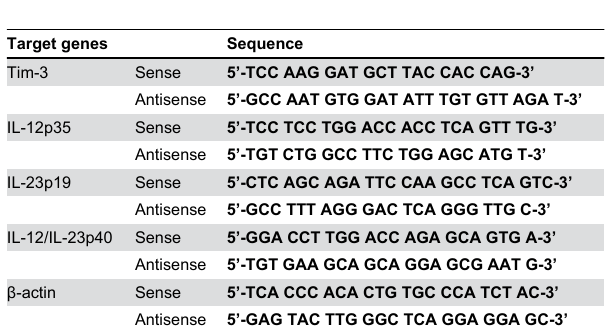
Table 1. Primers for Tim-3, IL-12p35, IL-23p19, and IL-12/ IL-23p40 gene